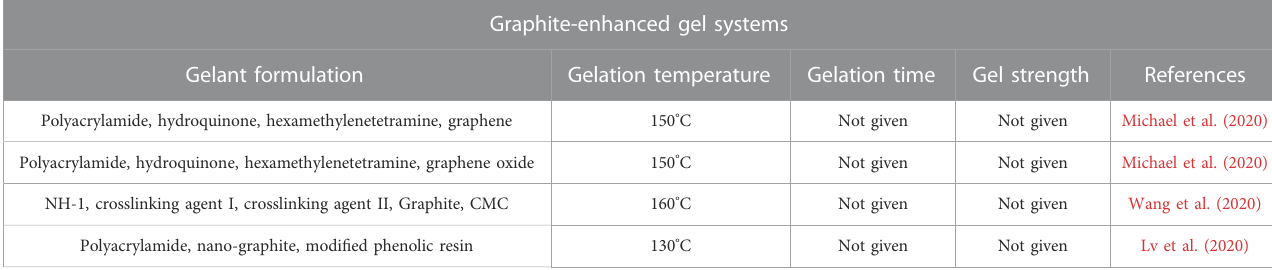
TABLE 3 Progress of graphite-enhanced gel